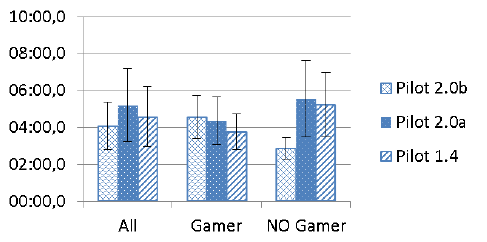
Figure 9. Performance in terms of time (means and SDs for differen groups of